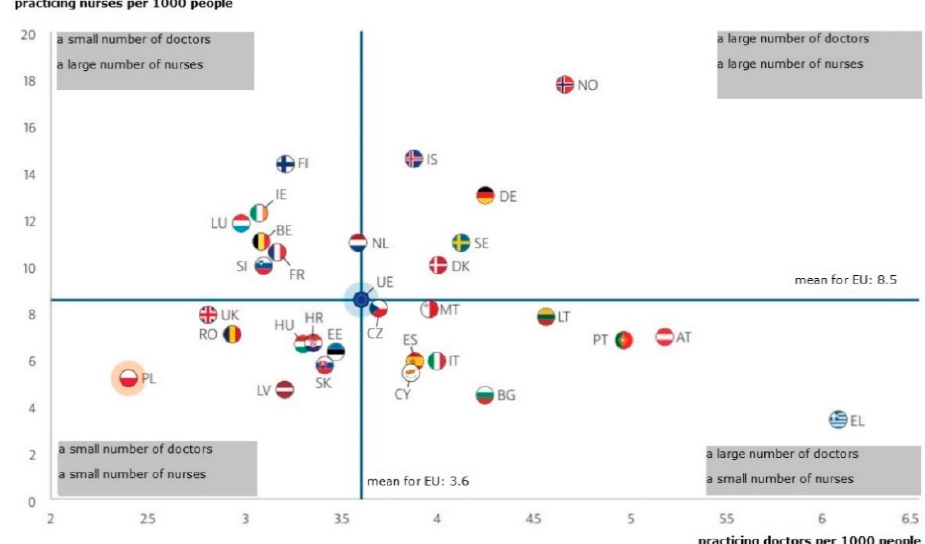
Figure 2. The number of doctors and nurses per one thousand inhabitants in individual EU countries. Note: for Portugal and Greece, the data refer to all licensed doctors, resulting in a significant overestimation of the number of practicing doctors (e.g., by around 30% for Portugal). For Austria and Greece, the number of nurses is underestimated as it only includes nurses working in hospitals. Source: OECD/European Observatory on Health Systems and Policies (2019), Poland: Country Health Profile 2019, State of Health in the EU, OECD Publishing, Paris/European Observatory on Health Systems and Policies, Brussels